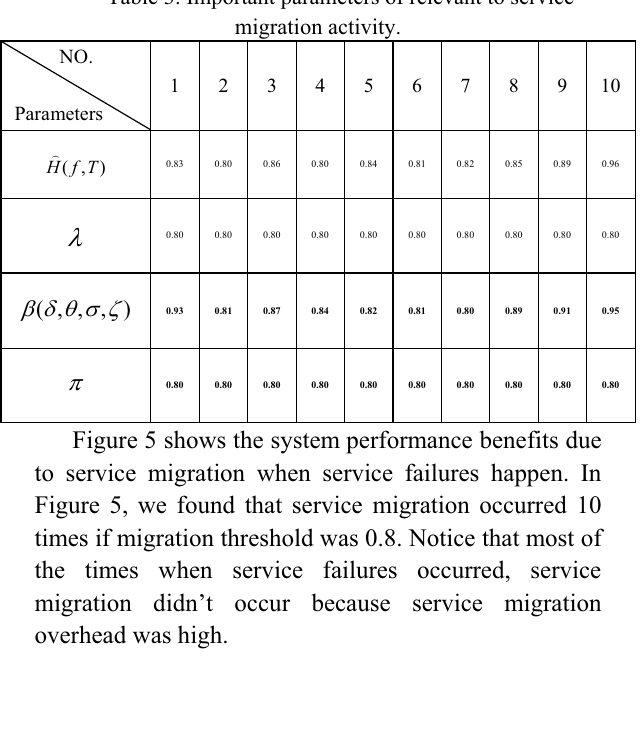
Fig. 4. The comparison of three different approaches to select service resources.